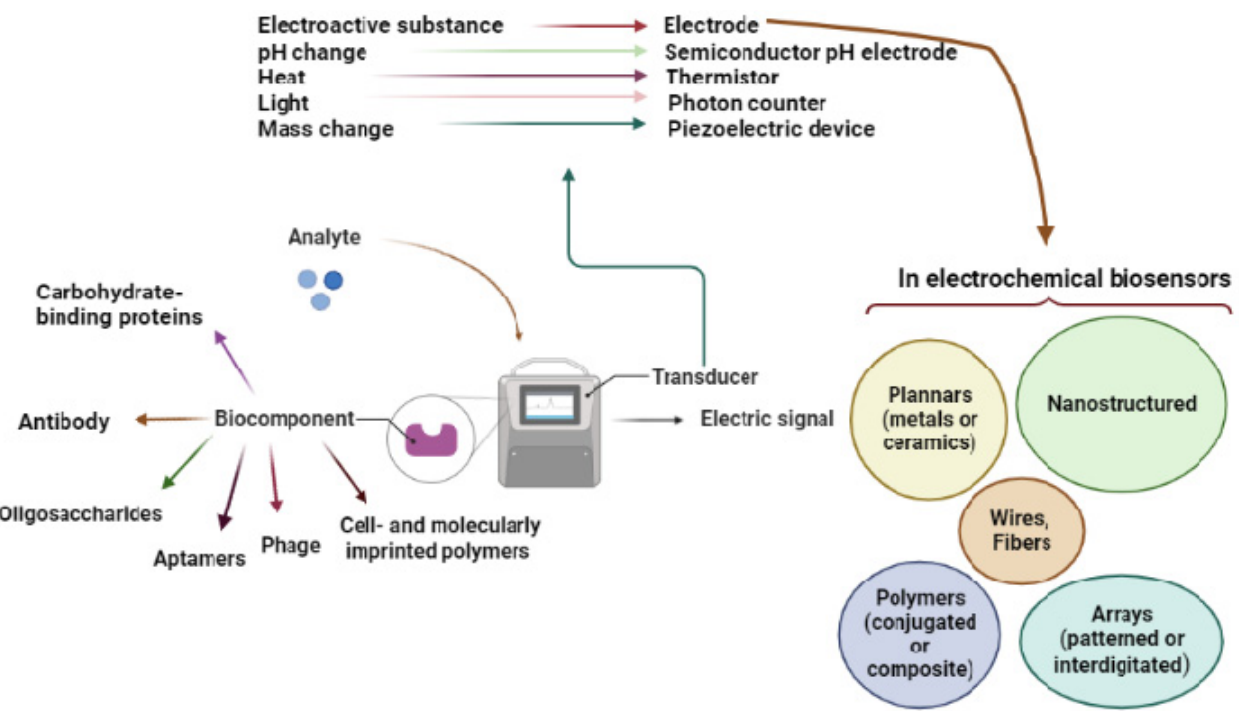
Figure 1. Overview of the biosensor and its components.